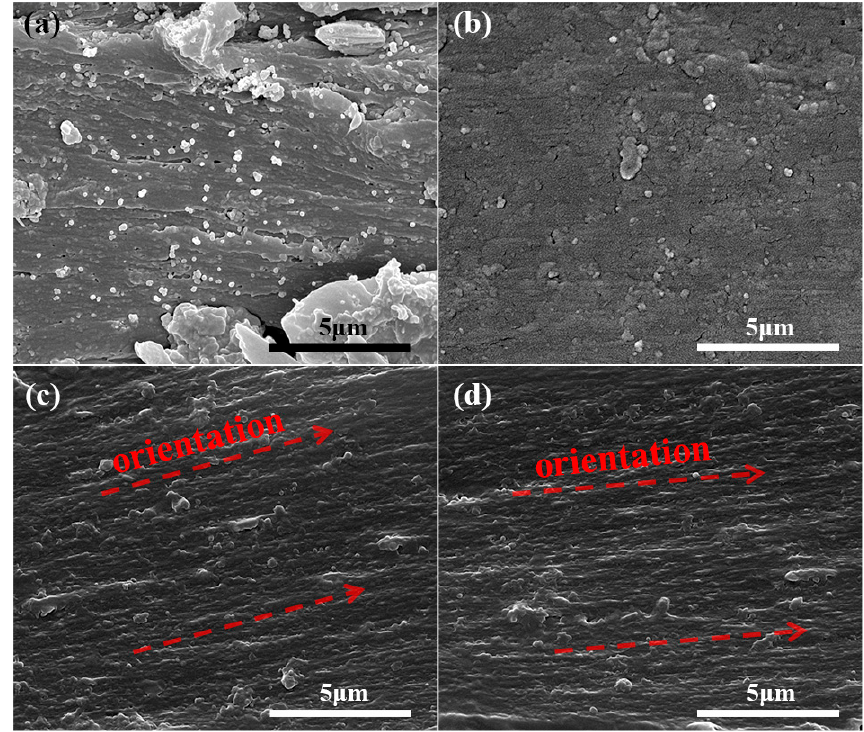
Figure 4. Cross-sectional scanning electron microscopy (SEM) images of ( a ) PEN/BT; ( b ) PEN/PANI- f -BT-b; ( c ) PEN/PANI- f -BT-b hot-stretched by 50%; ( d ) PEN/PANI- f -BT-b hot-stretched by 100%.